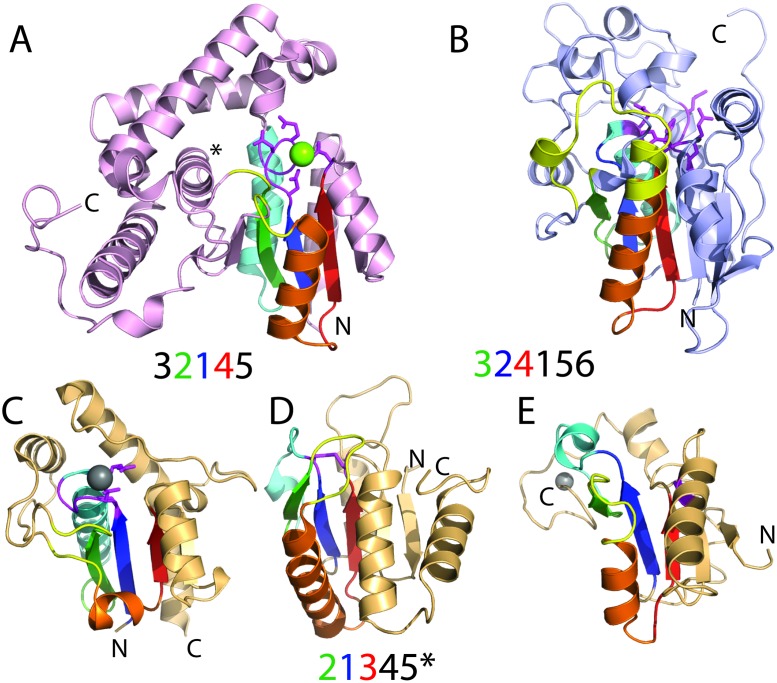
RLM protein phosphatases arose multiple times in evolution.Cartoon depictions are labeled at the termini. (A) HAD domain-like phosphatase (pink cartoon) adopts the parallel β-strand topology order indicated below and binds Mg2+ cofactor (green sphere) using the active site motif (magenta) from the RLM (rainbow). (B) PGM phosphatases (light blue cartoon) adopt the mixed β-strand topology order indicated below and catalyze metal-independent hydrolysis using a composite active site motif (magenta) that is both within and outside of the RLM (rainbow). Flavodoxin-like protein phosphatases (light orange cartoon, rainbow RLM, and magenta active site) fall into different ECOD T-groups with the typical flavodoxin-like β-strand order indicated below. The * denotes alternate T-group topologies for β-strand 5 (missing in panel C, permuted and antiparallel in panel D, and permuted in panel E). (C) Phosphotyrosine protein phosphatases I-like (D) (Phosphotyrosine protein) phosphatases II (E) rhodanese/cell cycle control phosphatase.